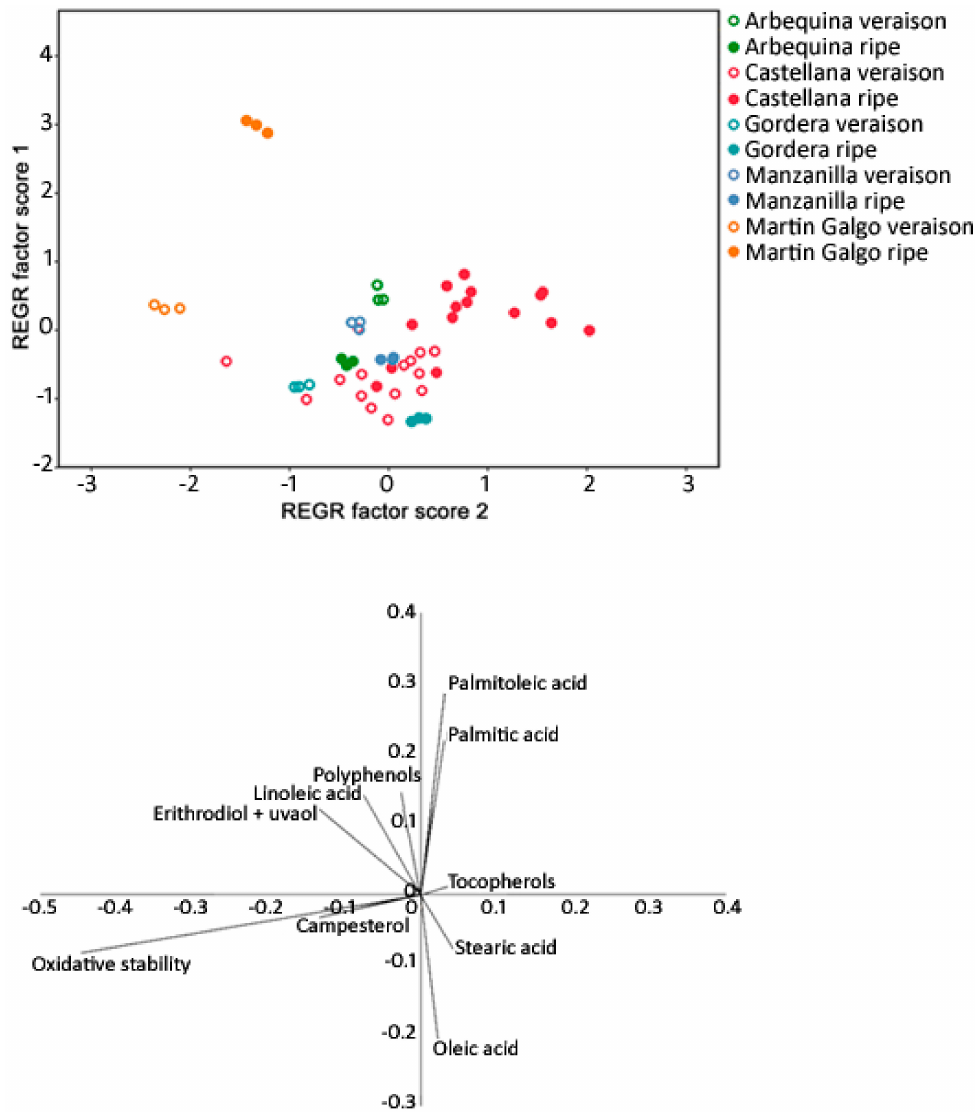
Figure 2. Principal Component Analysis (PCA) and weight of the